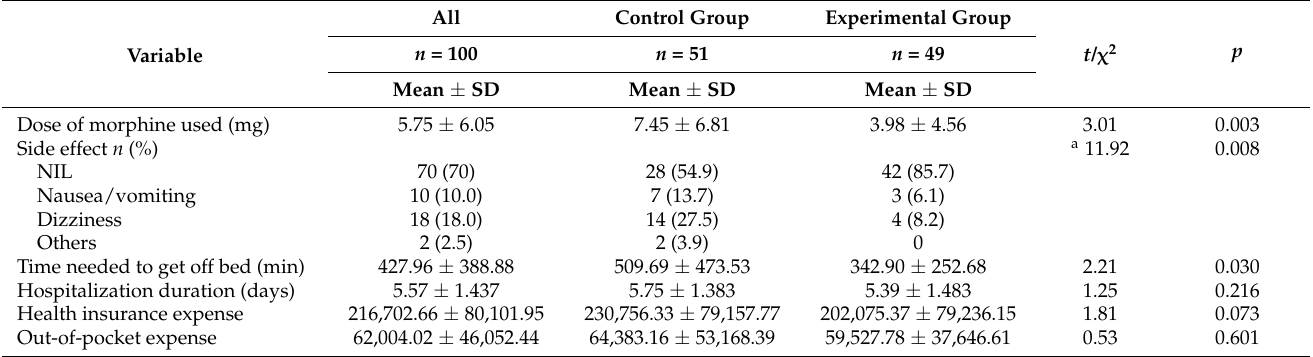
Table 1. Postoperative status of patients in both